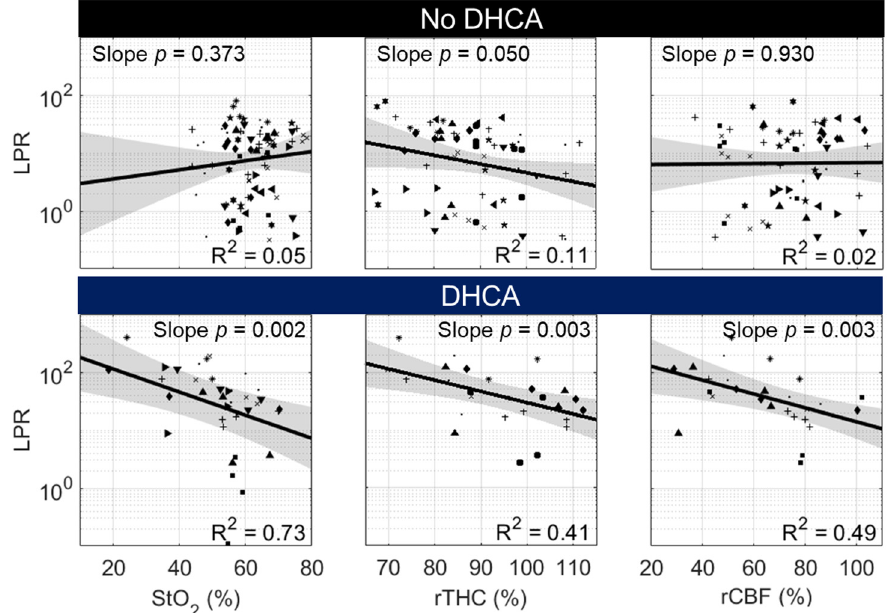
Figure 3. Correlation between the Cerebral Lactate–Pyruvate Ratio (LPR) and Cerebral Hemodynamics in “No DHCA” and DHCA Groups. Correlation data from individual animals are designated by a unique symbol within “No DHCA” animals (i.e., animals randomized to DHCPB and SACP groups) and, separately, within DHCA animals. No significant slope effect was detected in linear mixed-effects models examining the relationship between log-normalized LPR and StO 2 , rTHC, or rCBF data acquired during and following deep hypothermia in the “No DHCA” animals. By contrast, DHCA animals demonstrated a significant negative slope effect ( p < 0.05) in identical